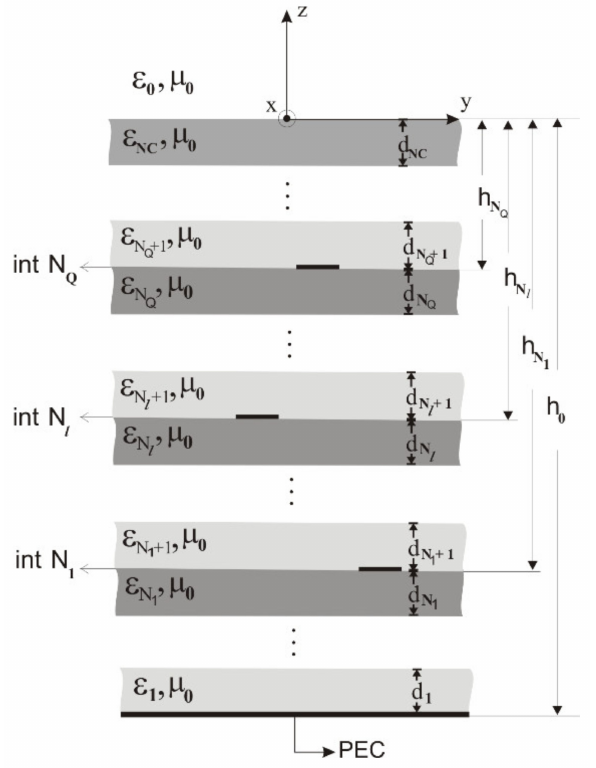
Figure 1. Side view of a multilayer medium which hosts Q interfaces with planar